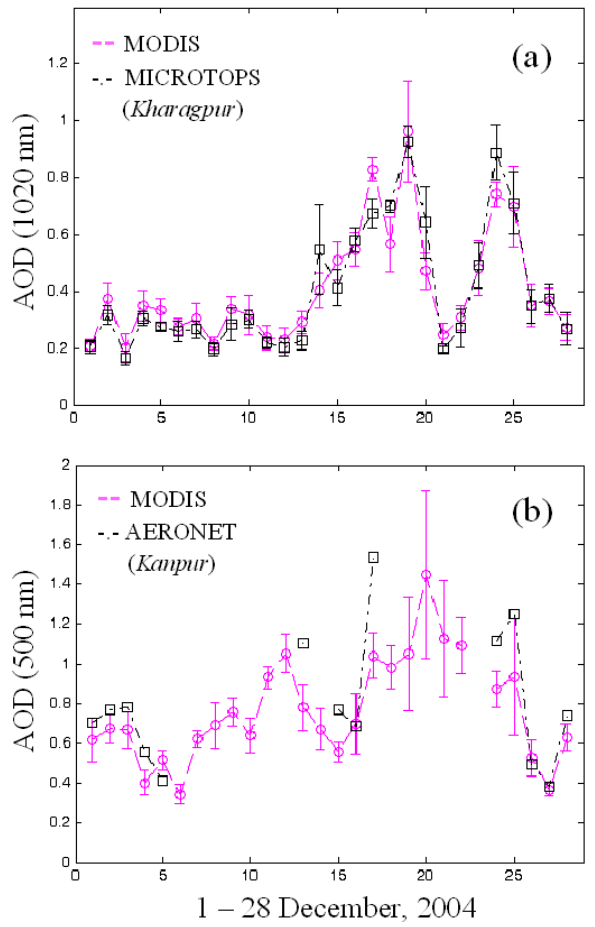
Fig. 1. Time series of MODIS derived AOD normalised to 1020nm along with its standard deviation and MICROTOPS measured AOD at 1020nm along with its standard error, for Kharagpur (a) and MODIS derived AOD normalised to 500nm along with its standard deviation and AERONET retrieved AOD at 500nm for Kanpur (b) during